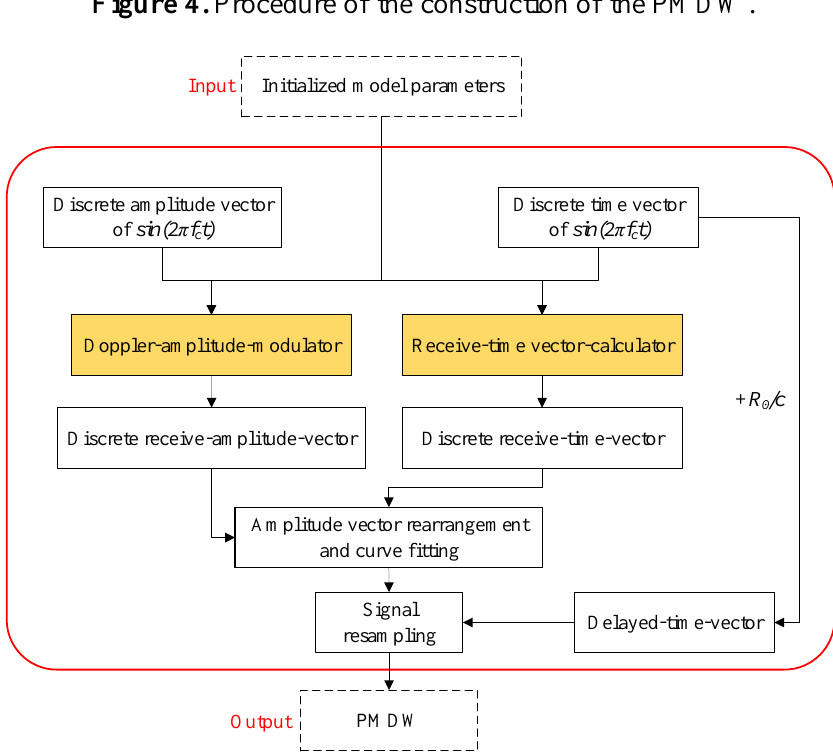
Figure 4. Procedure of the construction of the PMDW.